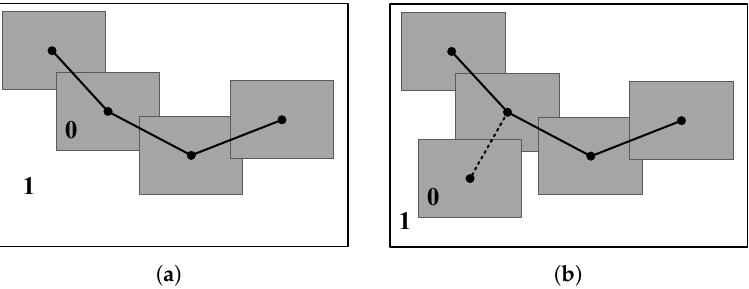
Figure 3. Weighted sampling method to guide the tree grow. ( a ) The tree before generating a new node. ( b ) The tree after growing a new node in the lower-left corner. The weights in the rectangular neighborhood of the node are set to